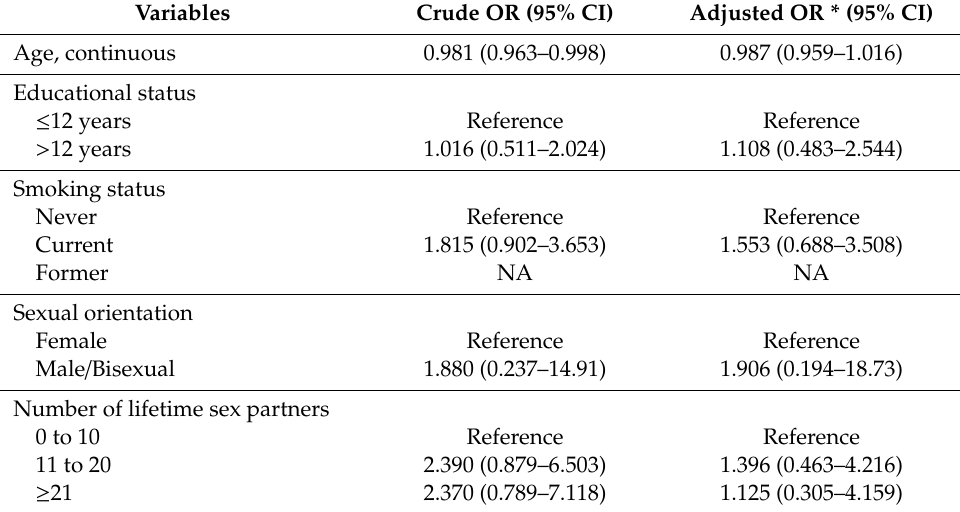
Table 5. Predictors against HPV infection targeted by the 4v HPV